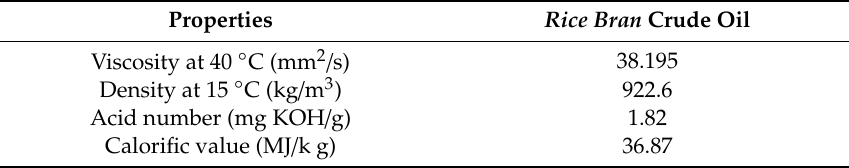
Table 3. Physical and chemical properties of the crude rice bran crude oil